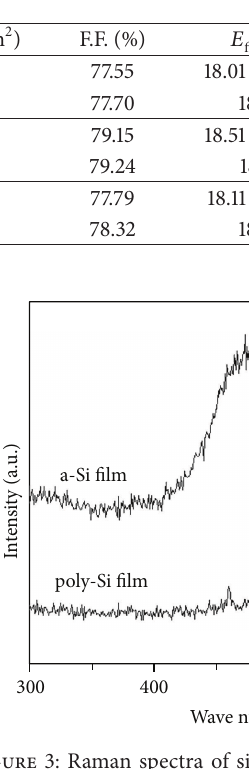
Table 1: Electrical characteristics of solar cell parameters measured under the standard test condition (25 ∘ C, AM 1.5 G). The average and best efficiencies obtained in the measurement are shown for each group of solar cells. Series resistances and shunt resistances for the best cell and the average are also shown.